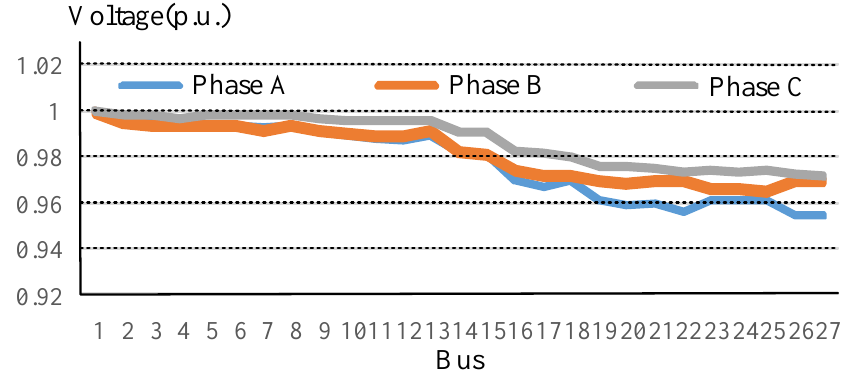
Figure 4. The three-phase voltage profiles of each bus before phase rearrangement at the light load period.